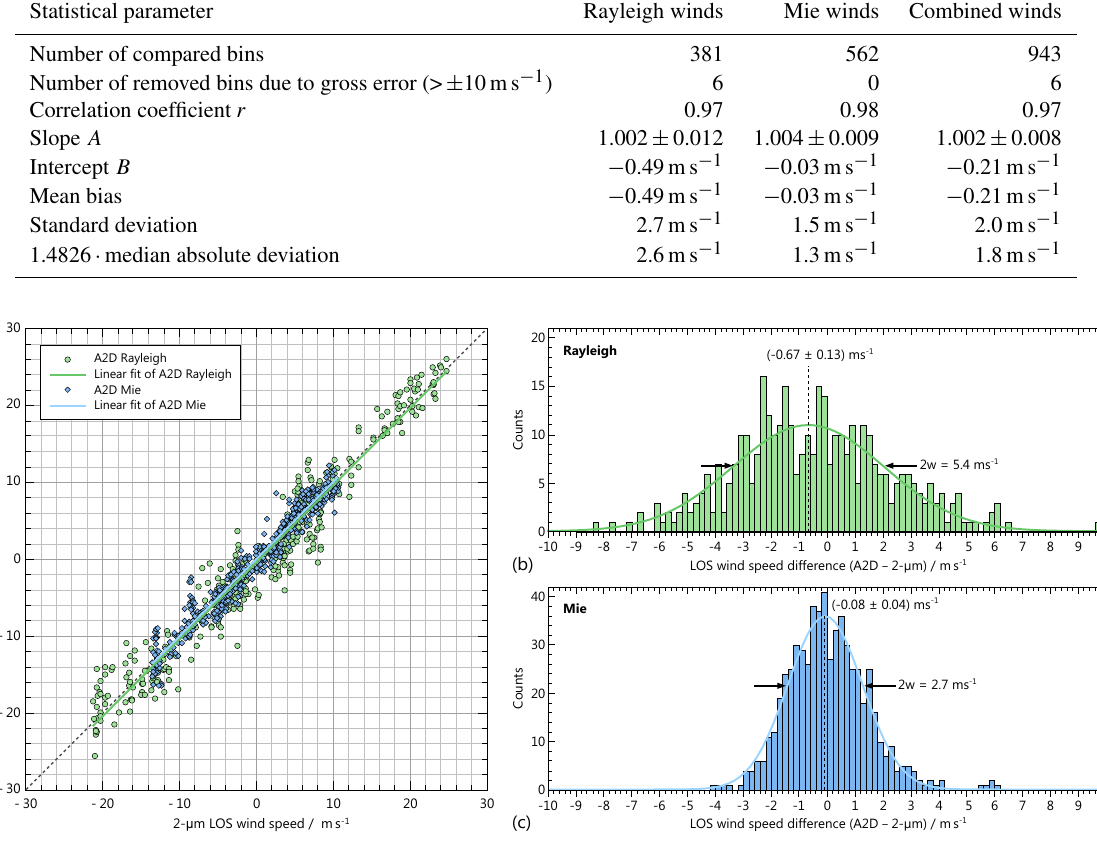
Table 4. Results of the statistical comparison between the A2D and the 2µm LOS wind data measured on 27 September 2016. The statistical comparison has been performed for the Rayleigh and Mie wind profiles (see corresponding scatterplots in Fig. 9) as well as for the combined wind curtain as shown in Fig. 7c.